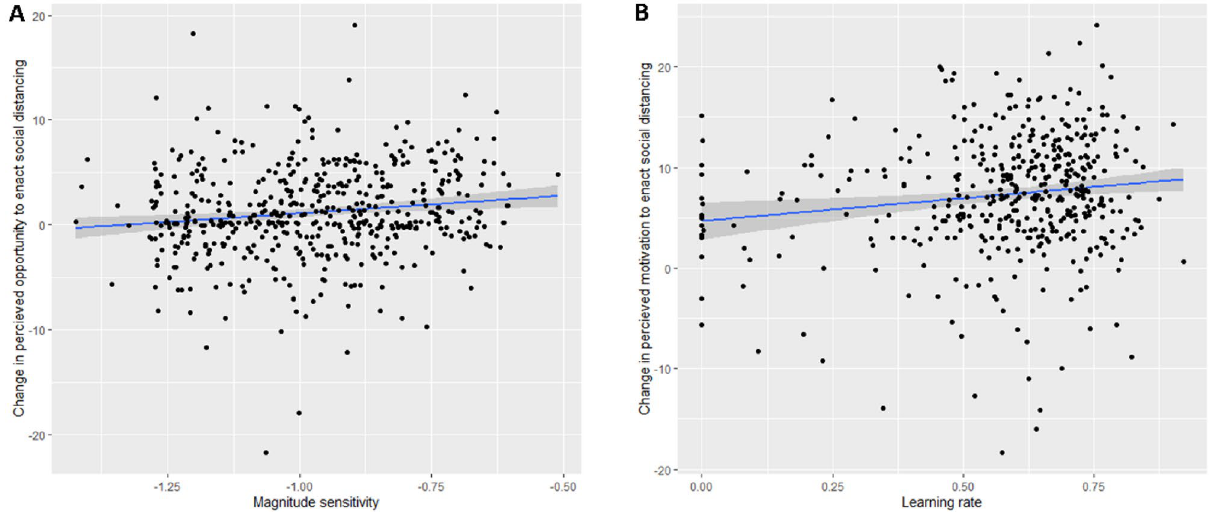
Figure 4. ( A ) Steeper delay discounting magnitude effect (lower values on the x-axis) predicted a greater reduction (T2 − T1) in perceived opportunity to adhere to social distancing. ( B ) Lower learning rate predicted decreased motivation to engage in social distancing. Regression lines are highlighted in